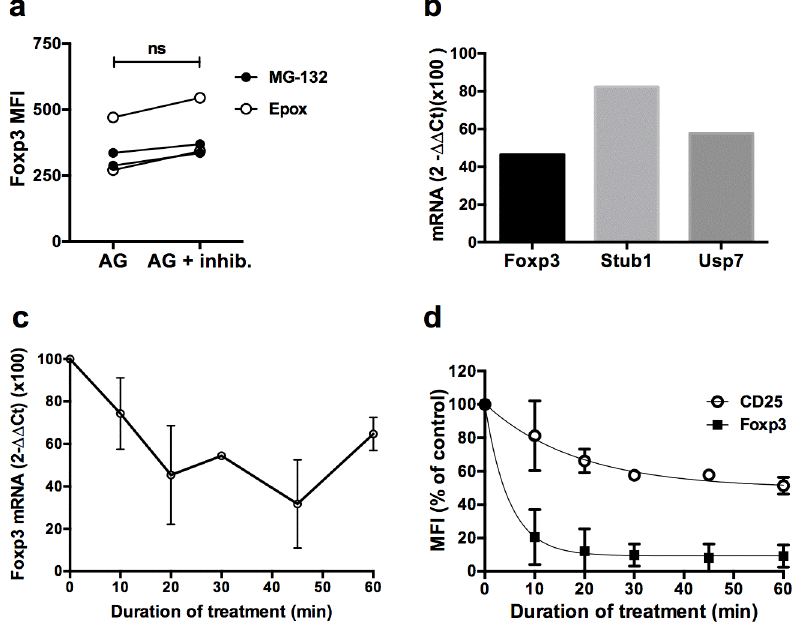
Fig 3. Rapid turn over of the Foxp3 protein and mRNA in Treg. (a) MFI of Foxp3 on GFP + Treg treated with proteasome inhibitors MG-132 or Epoxomycine (Epox) in presence of IL-2 and AG for 2 hrs. Cells were pretreated during 2 hrs with the proteasome inhibitors before adding AG. (b) Foxp3, USP7 and STUB1 mRNA were quantified using the TaqMan RT-PCR assay normalized to vehicle control conditions 45 minutes after AG-treatment in expanded CD4 + GFP + cells by the 2 - ΔΔ Ct method (see method section). This result originate from a single experiment performed in triplicates. (c) Foxp3 mRNA was assessed by quantitative RT-PCR normalized to vehicle control conditions at the indicated times after AG-treatment in expanded CD4 + GFP + cells by the 2 - ΔΔ Ct method (see method section). The experiment was repeated 3 times. Each dot represent the mean ± SDEV of results obtained in 3 independent experiments. Two outliers were removed from the calculation (d) MFI of Foxp3 and CD25 in cycloheximide-treated sorted activated CD4 + GFP + cells relative to the vehicle control at the indicated times. Results are compiled from 3 independent